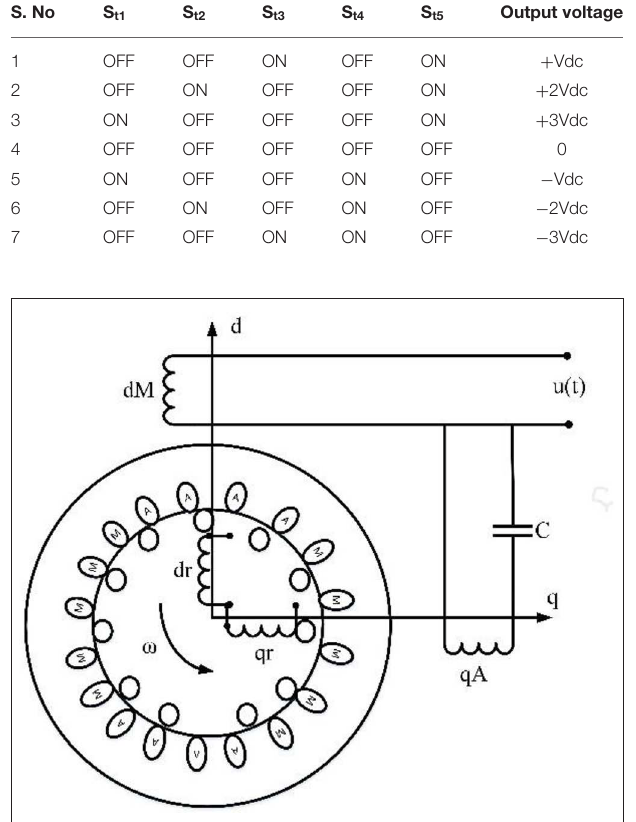
FIGURE 3 | Perspective of dq model representation for single-phase induction